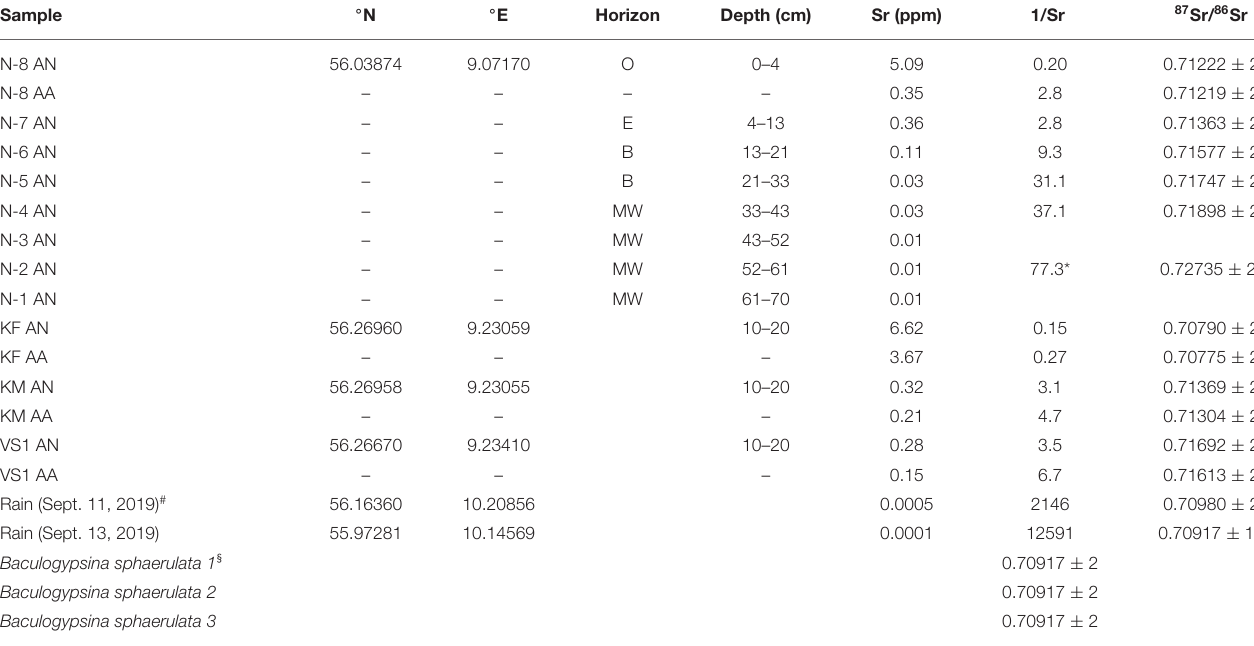
TABLE 1 | Strontium isotopic compositions and concentrations of analyzed soil samples and samples of rainwater and samples of modern day foraminifera analyzed for quality control.